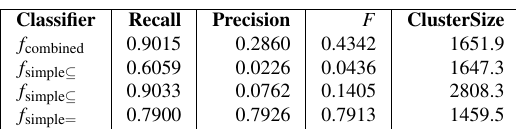
Table 8. Classification